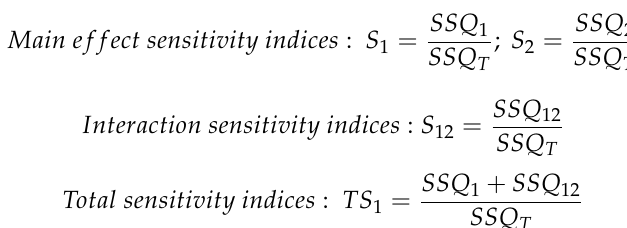
Table 2. Parameters selected for sensitivity analysis and calibration of cereal rye phenology and biomass in APSIM. Parameter Description Default Value Plant extractable soil water in pesw_germ * seedling layer inadequate for germination (mm/mm) The potential period from tt_end_of_juvenile * end of juvenile stage to terminal spikelet stage ( ◦ Cd)